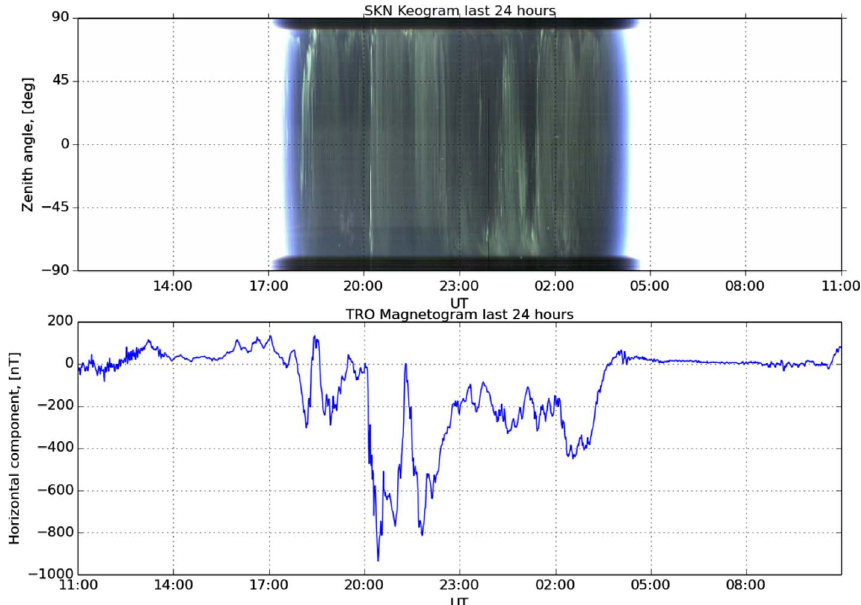
Fig. 4. (a) Keogram obtained for the geographic N – S meridian with the ASC located at the Skibotn Observatory on March 5, 2017, (b) horizontal component of the magnetic fi eld recorded at the Tromsø observatory the same day. Both diagrams illustrate a very high auroral activity during the observations with Premier Cru.